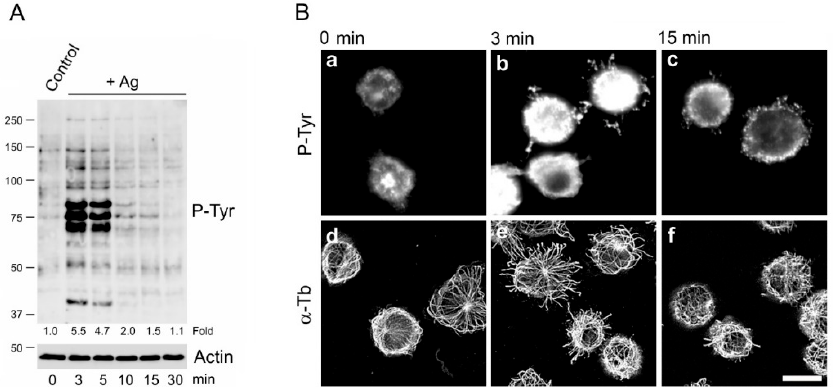
Figure 1. The antigen-induced activation of bone marrow-derived mast cells (BMMCs) results in a transient increase of the phosphorylation of proteins on tyrosine and the spatial redistribution of microtubules. ( A ) A comparison of the protein tyrosine phosphorylation level (P-Tyr) on blots from whole-cell lysates of controls and cells activated by Fc ε RI aggregation ( + Ag) using an antigen (100 ng / mL) for various time intervals: Actin served as the loading control. Representative image, out of three repetitions, is shown. The numbers under the blot indicate the relative amounts of P-Tyr normalized to unstimulated control cells and the amount of actin in individual samples. ( B ) IgE-sensitized cells activated with antigen (100 ng / mL) for various time intervals were fixed and stained for tyrosine-phosphorylated proteins ( a – c ) and α -tubulin ( d – f ). Fixation F / Tx. Scale bar, 10 µ m. It is well established that non-transmembrane Src homology 2 (SH2) domain-containing protein tyrosine phosphatases (SH-PTPs; SHPs) are critical regulators of intracellular signaling in activated